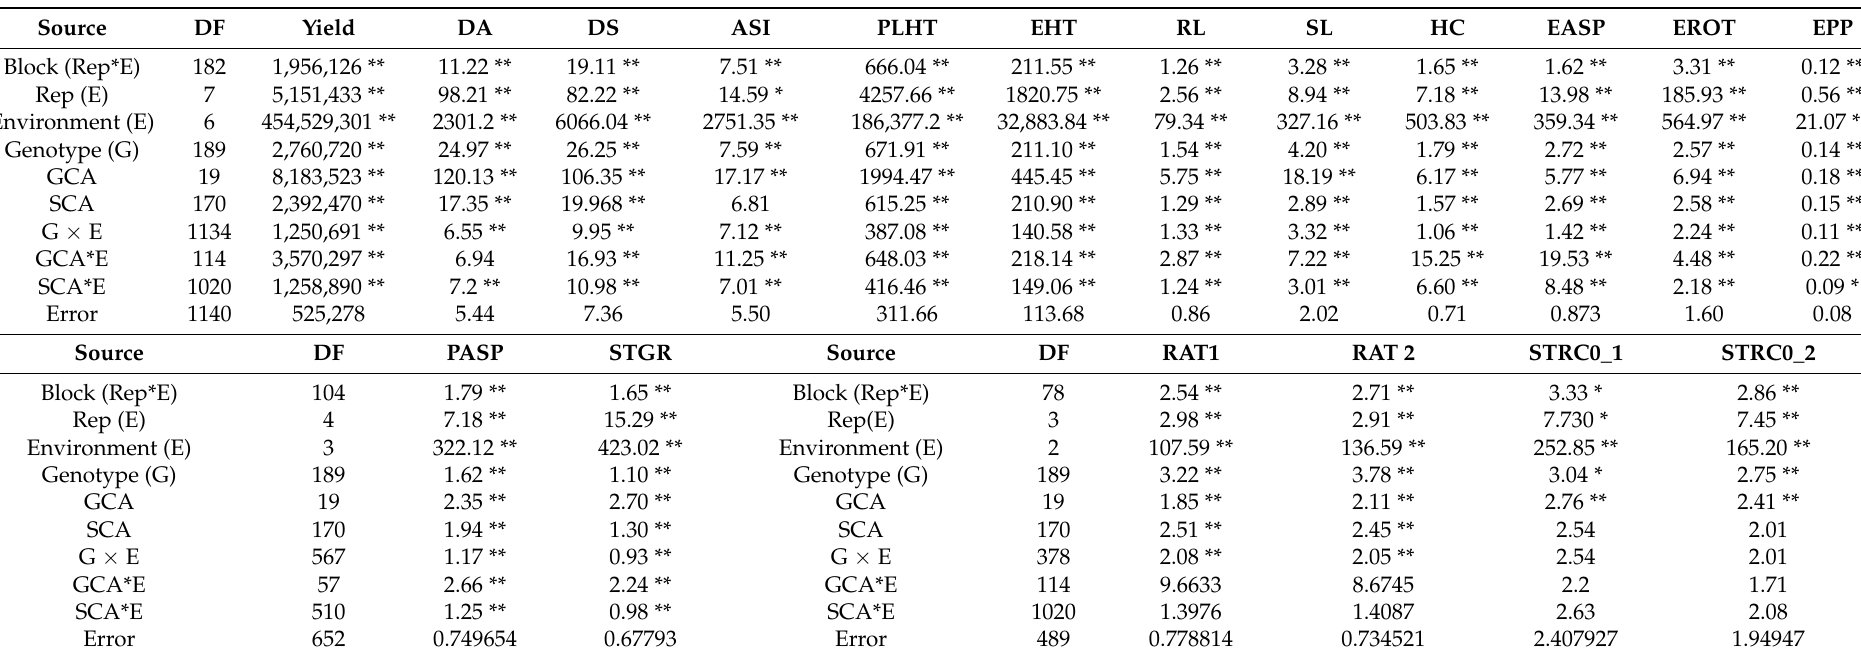
Table 2. Mean squares from the ANOVA of grain yield and other agronomic traits of 190 early maturing pro-vitamin A hybrids and 6 hybrid checks evaluated across three stress conditions (drought, low-N and under Striga infestation) in 2016 and 2017 in Nigeria. Source